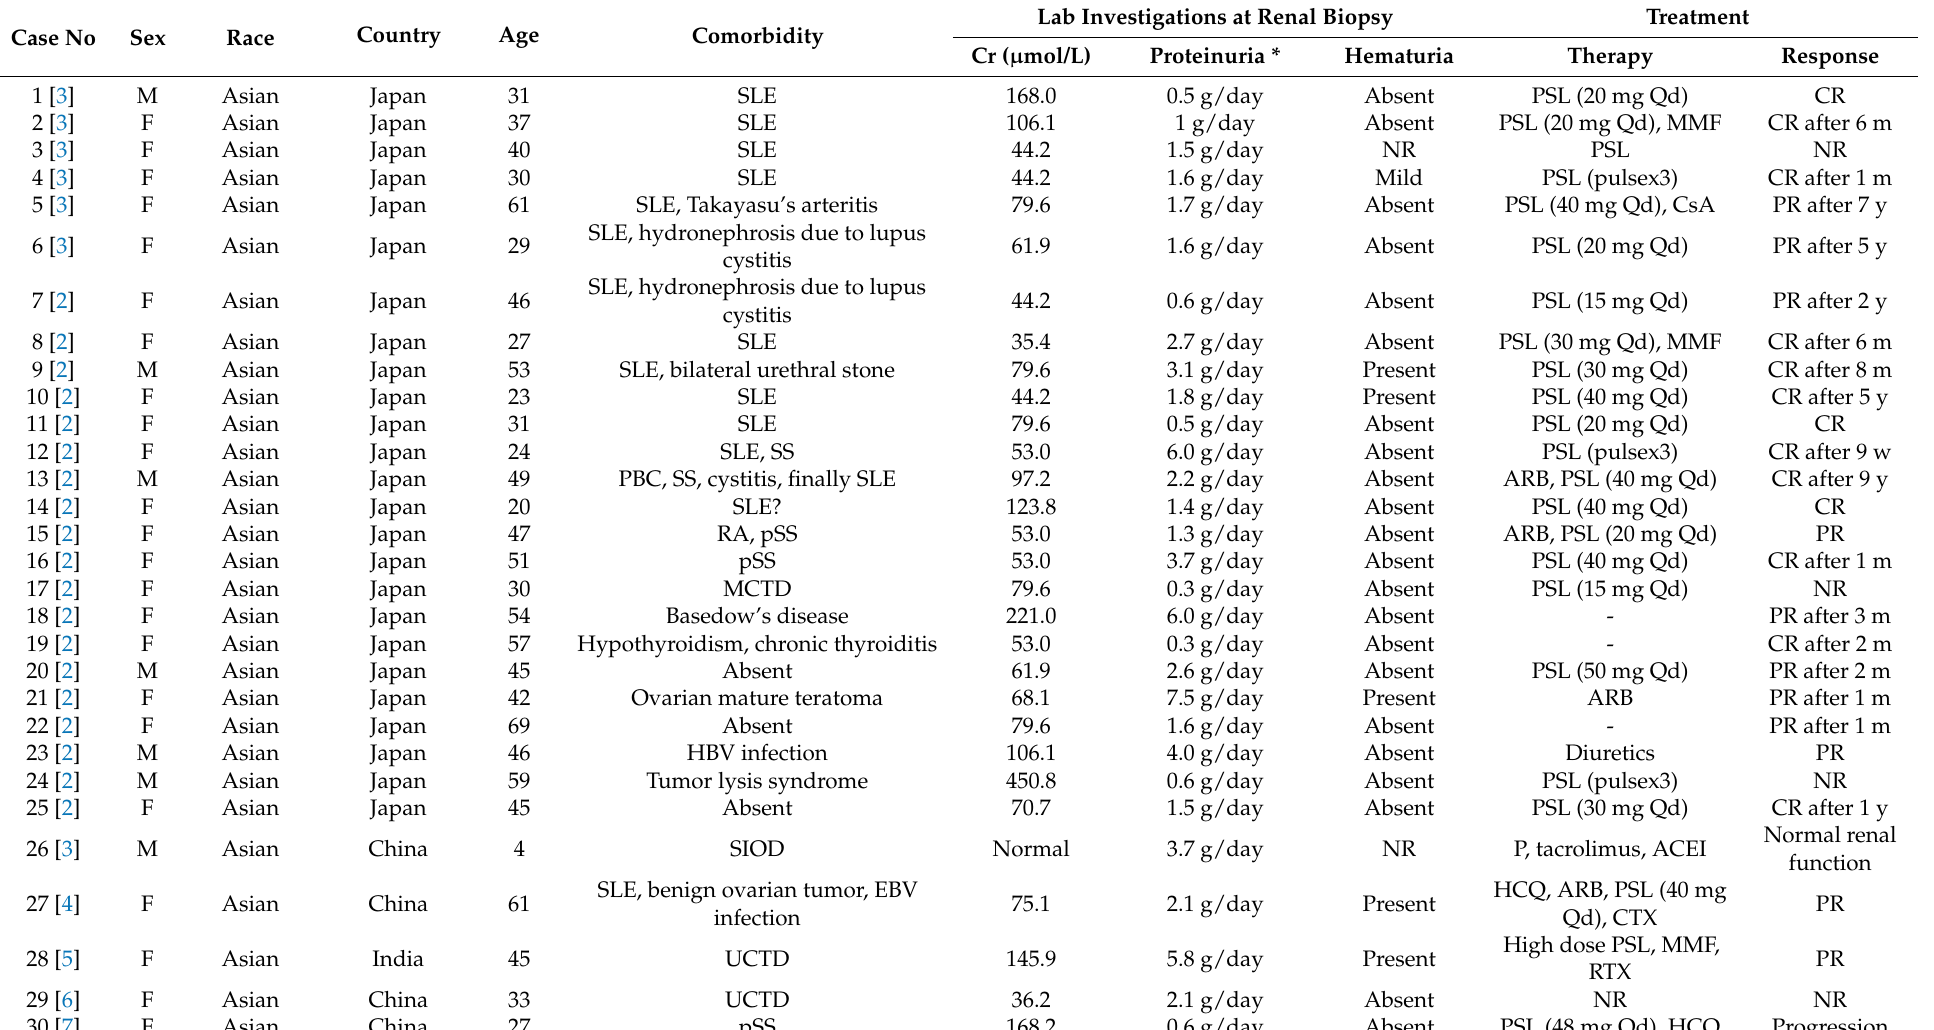
Table 1. Characteristics of clinical profiles of PIG cases reported in the literature and in this case